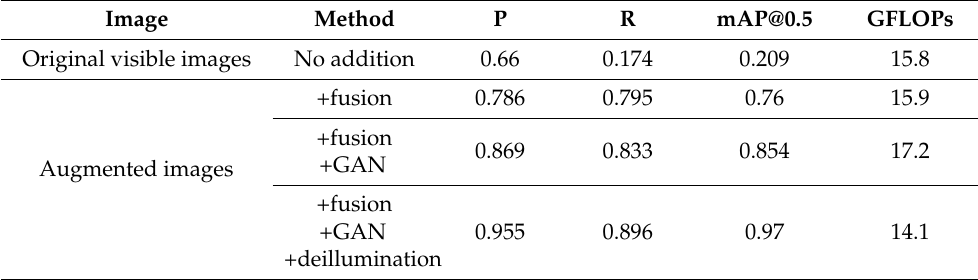
Table 4. The overall comparison results for pedestrian detection.